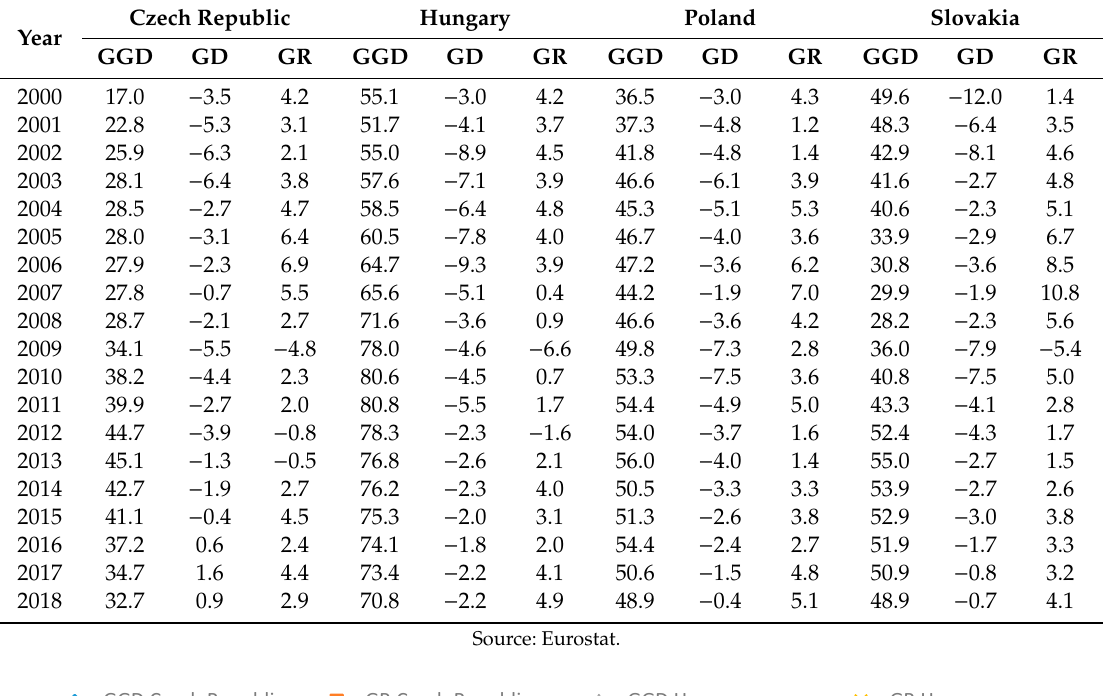
Table 2. Central and Eastern European countries’ GGD percentage of GDP, GD percentage of GDP, and growth rate percentage change from previous year, 2000–2018.